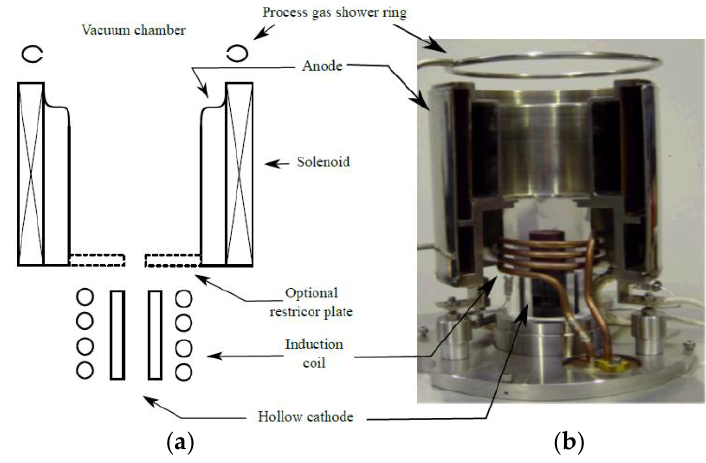
Figure 1. Plasma source schematic ( a ) and cross-section photo ( b ) (plasma source dimensions: height 200 mm; width 150 mm). Hollow cathode material is lanthanum hexaboride and restrictor plate material boron nitride. Main body (anode) material is water-cooled stainless steel. The generated thermionic electrons from the inductively heated lanthanum hexaboride hollow cathode and anode. This results in ionization of heavier gas atoms such as argon, separately